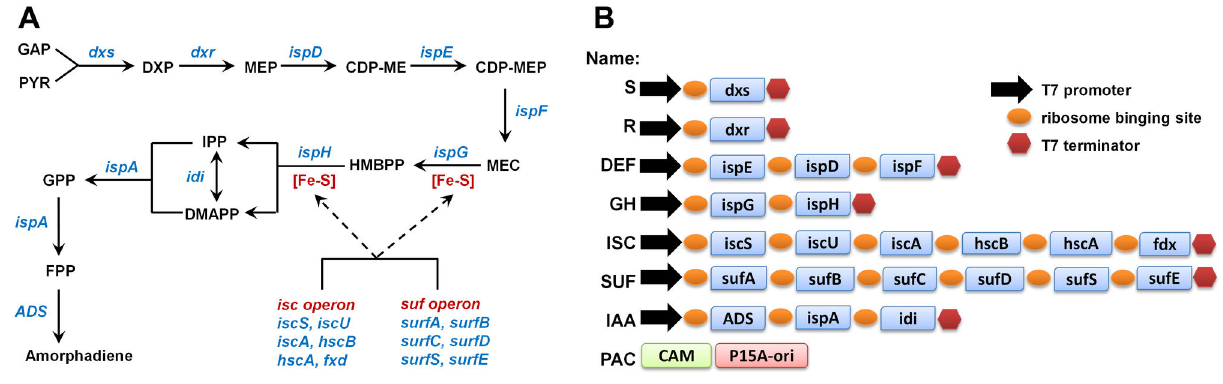
Figure 3. Optimization of CLIVA method. ( A ) Optimization of cations using the assembly of PAC-SIDF plasmid with O12-13/4-5 design (12-13 bases overlap with modification at every 4-5 bases). ( B ) The transformation efficiency of PAC-SIDF plasmid in the presence of MgCl . ( C ) The effect of the phosphorothioate modification frequency on the assembly efficiency. O12-13/4-5, 2 O12-13/6-7, O12-13/12-13 designs: 12-13 bases overlap with modification at every 4-5 bases, 6-7 bases or 12-13 bases. ( D ) The effect of overlap length on the assembly efficiency. O12-13/4-5, O24-25/4-5, O36-38/4-5 designs: 12-13 bases, 24-25 bases, 36-38 bases overlap with modification at every 4-5 bases. All the experiments were done at triplicates and the standard errors were shown in the figure. doi: